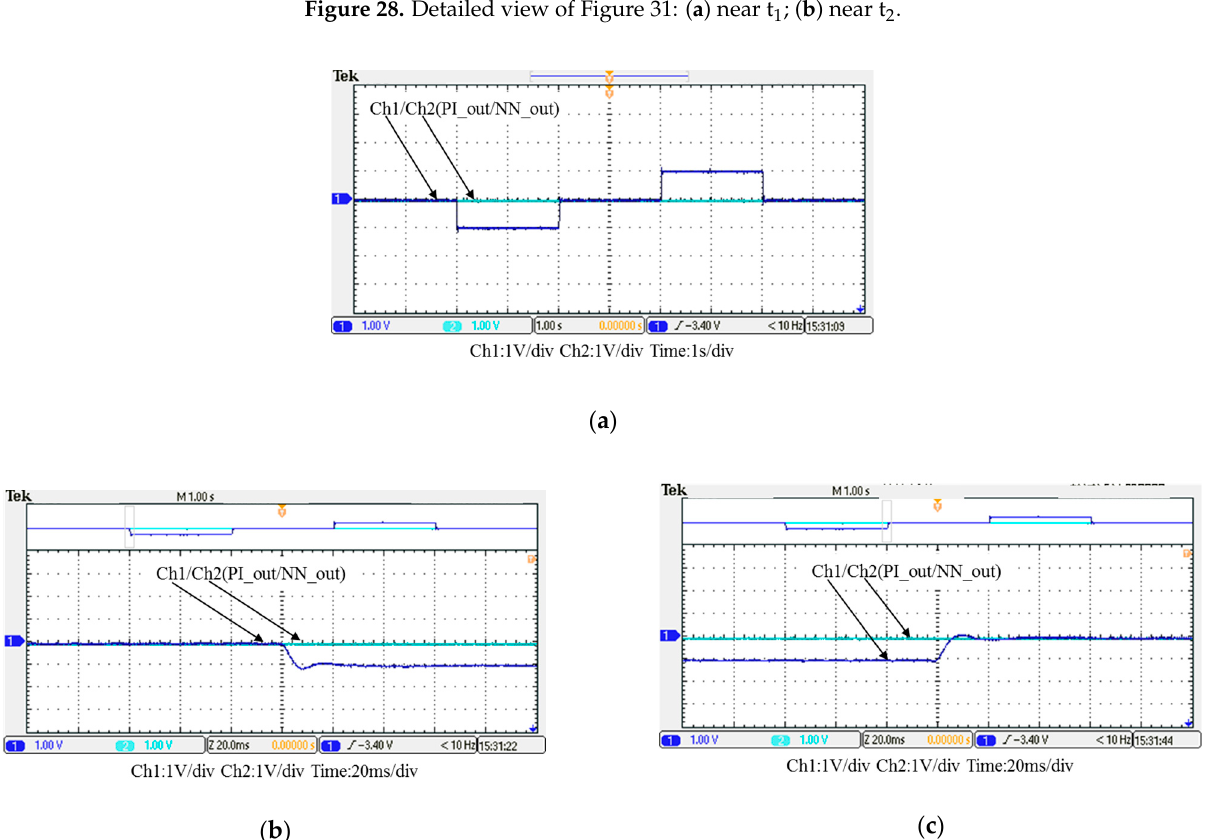
Figure 28. Detailed view of Figure 31: ( a ) near t 1 ; ( b ) near t 2 .